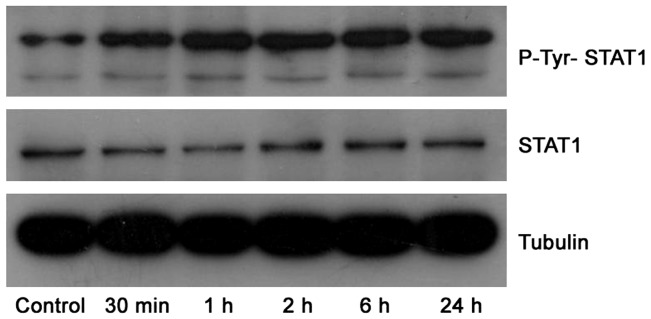
Changes of P-Tyr-STAT1 and STAT1 expression after KGF treatment in LoVo cells.Increased expression of P-Tyr-STAT1, but not STAT1, were confirmed by western blot in LoVo cells with KGF (150 ng/ml) treatment. Tubulin was used as internal control.